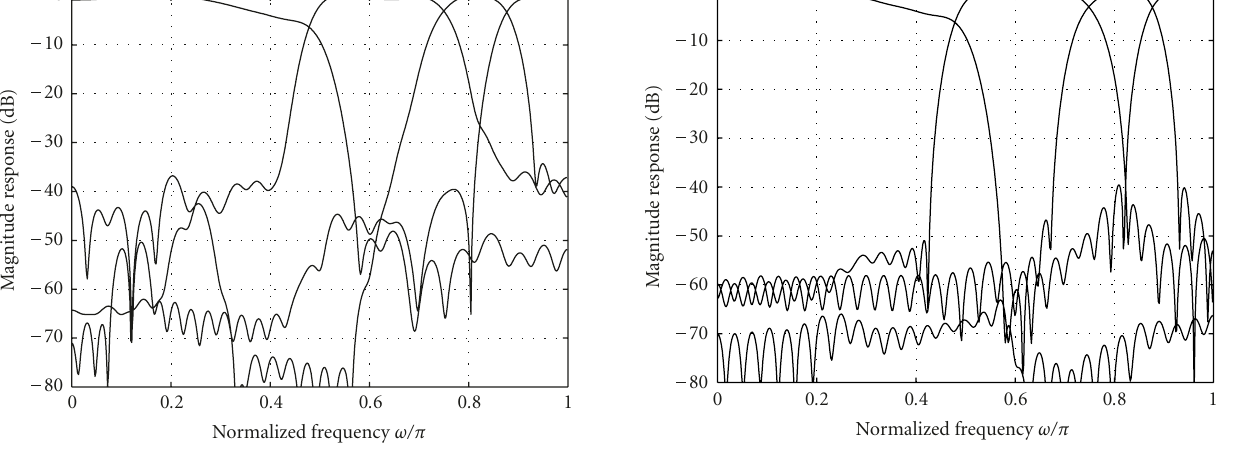
Figure 7: Magnitude responses of the receiving filters (no frequency criteria).